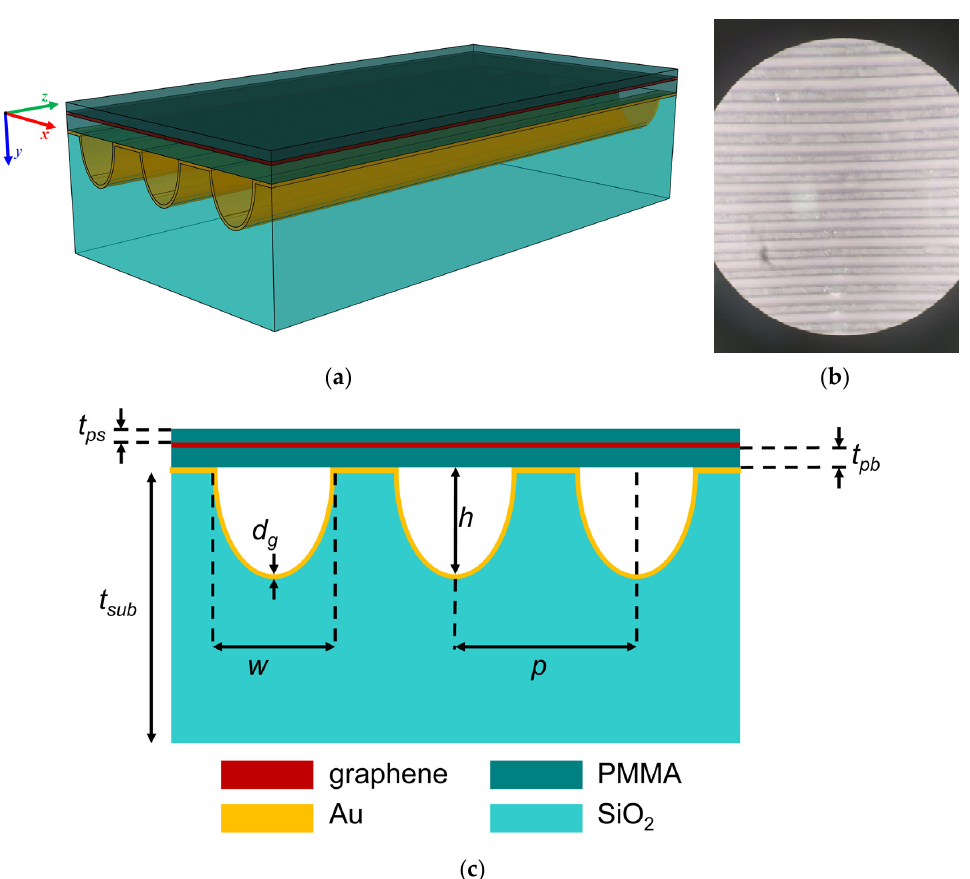
Figure 1. ( a ) Three-dimensional sketch of the graphene/gold/patterned SiO 2 metasurface. ( b ) Photo of the top view of the graphene/gold/SiO 2 patterned metasurface. ( c ) Cross-section of the metasurface.